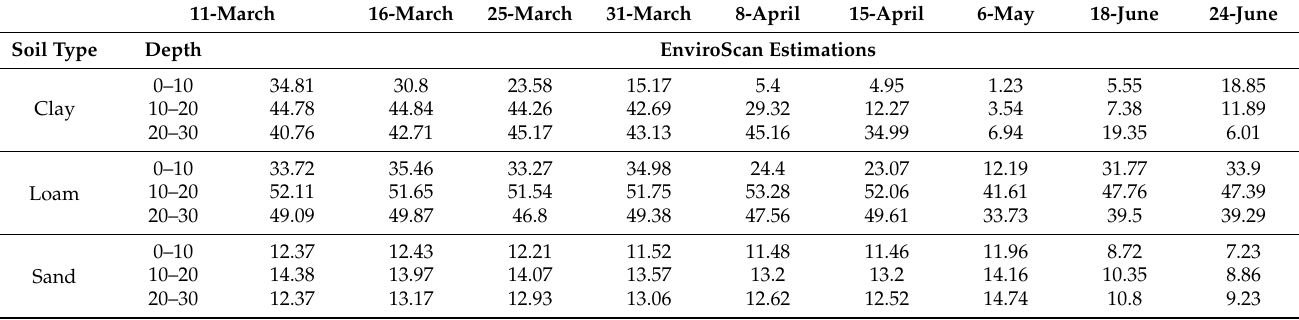
Table 4. Estimated Volumetric water content using the default Sentek calibration algorithm (Field Calibration—Phase